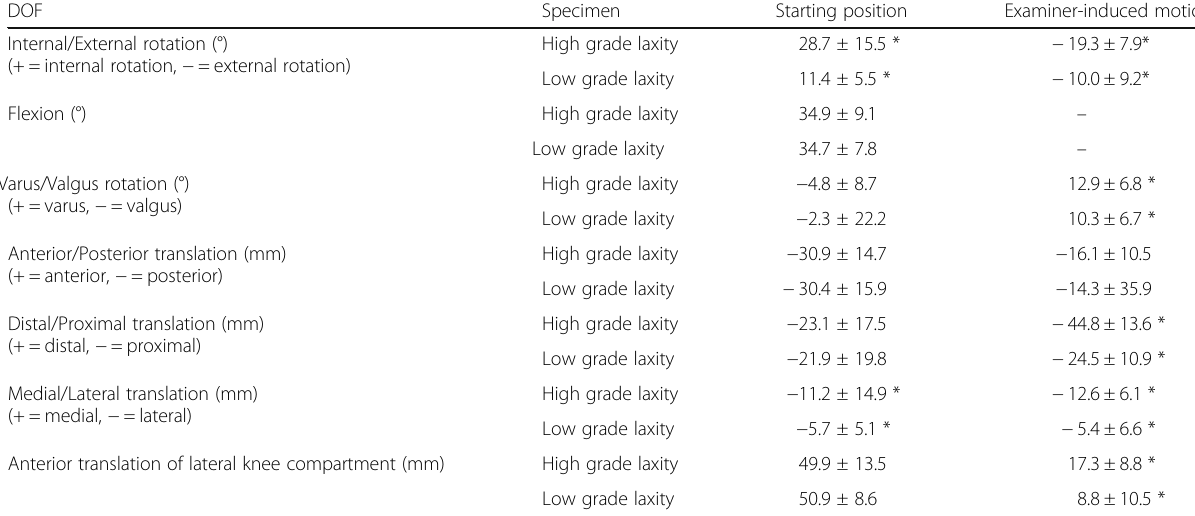
Table 1 Knee position at the start of the reduction event of the pivot shift test and examiner-induced motion during the reduction event (calculated as difference Δ between joint position at the start and at the end of the reduction event of the pivot shift) in the high grade laxity specimen and the low grade laxity specimen based on the Grood/Suntay coordinate system. Values are represented as average ± standard deviation